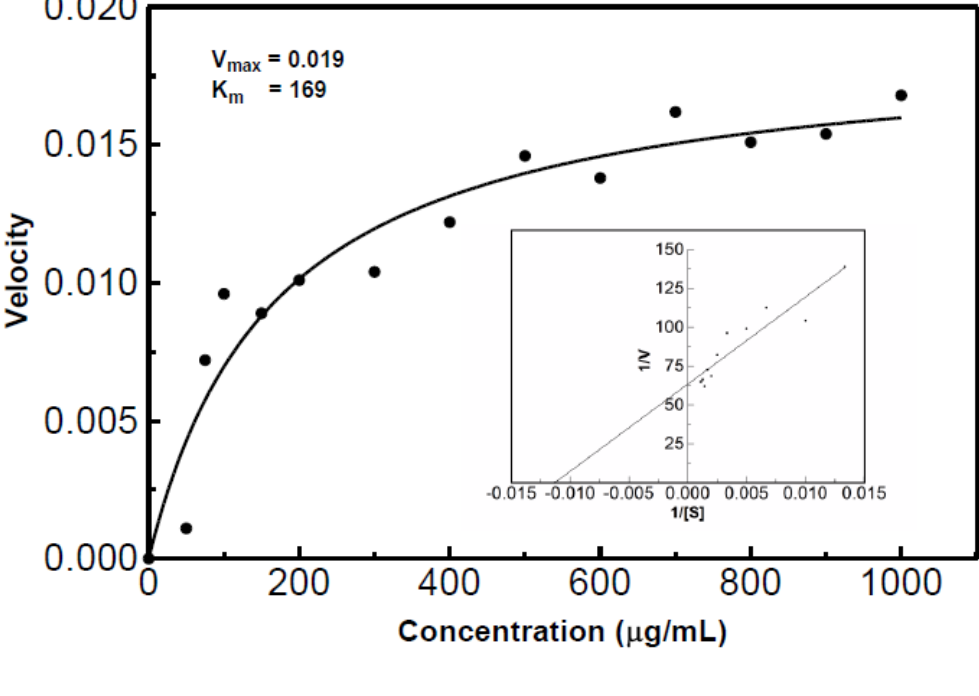
Figure 11. Michaelis-Menten and Lineweaver-Burk plots of RNase activity. The K was estimated to be 169 with a V of 0.019. The acid soluble assay at 55 °C with varying max RNA substrate concentrations was used to determine the velocities. The data was then converted to generate the Lineweaver-Burk